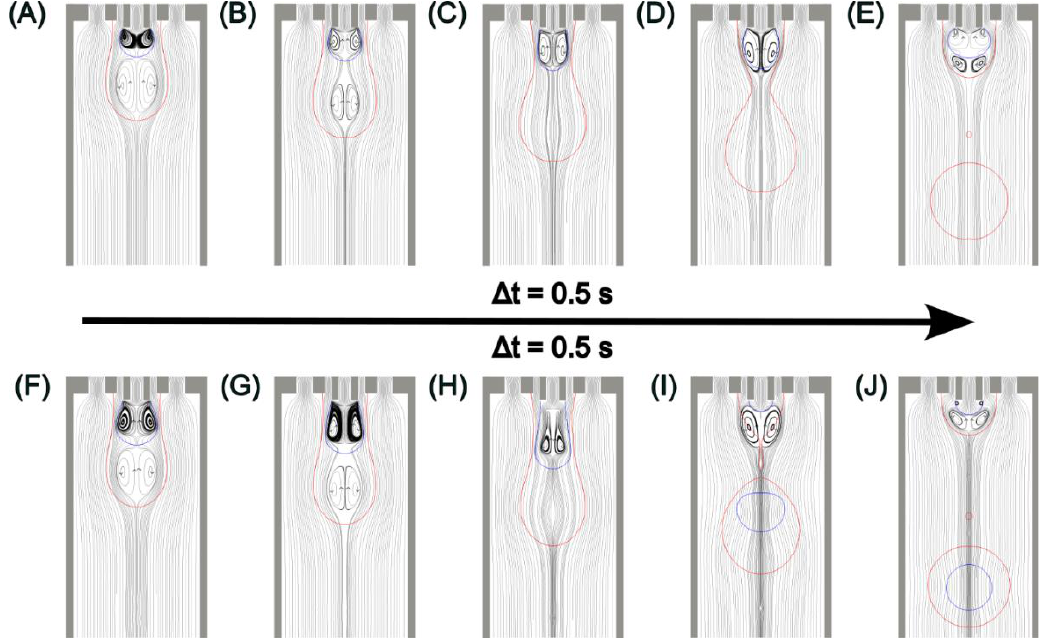
Figure 6. Velocity streamlines near the needle tip at Q 1 = 3 µL/min, Q 2 = 30 µL/min, Q 3 = 500 µL/min: ( A – E ) when the mismatch occurs; ( F – J ) when the core matches with the shell droplet.